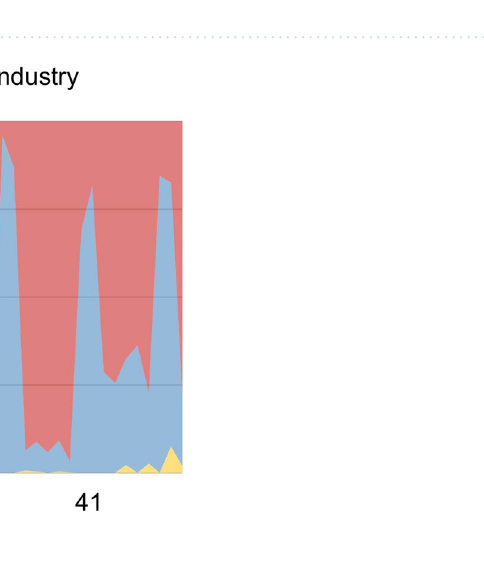
Figure 3. Time dependence of the share of each infection location in the total number of infections obtained from the